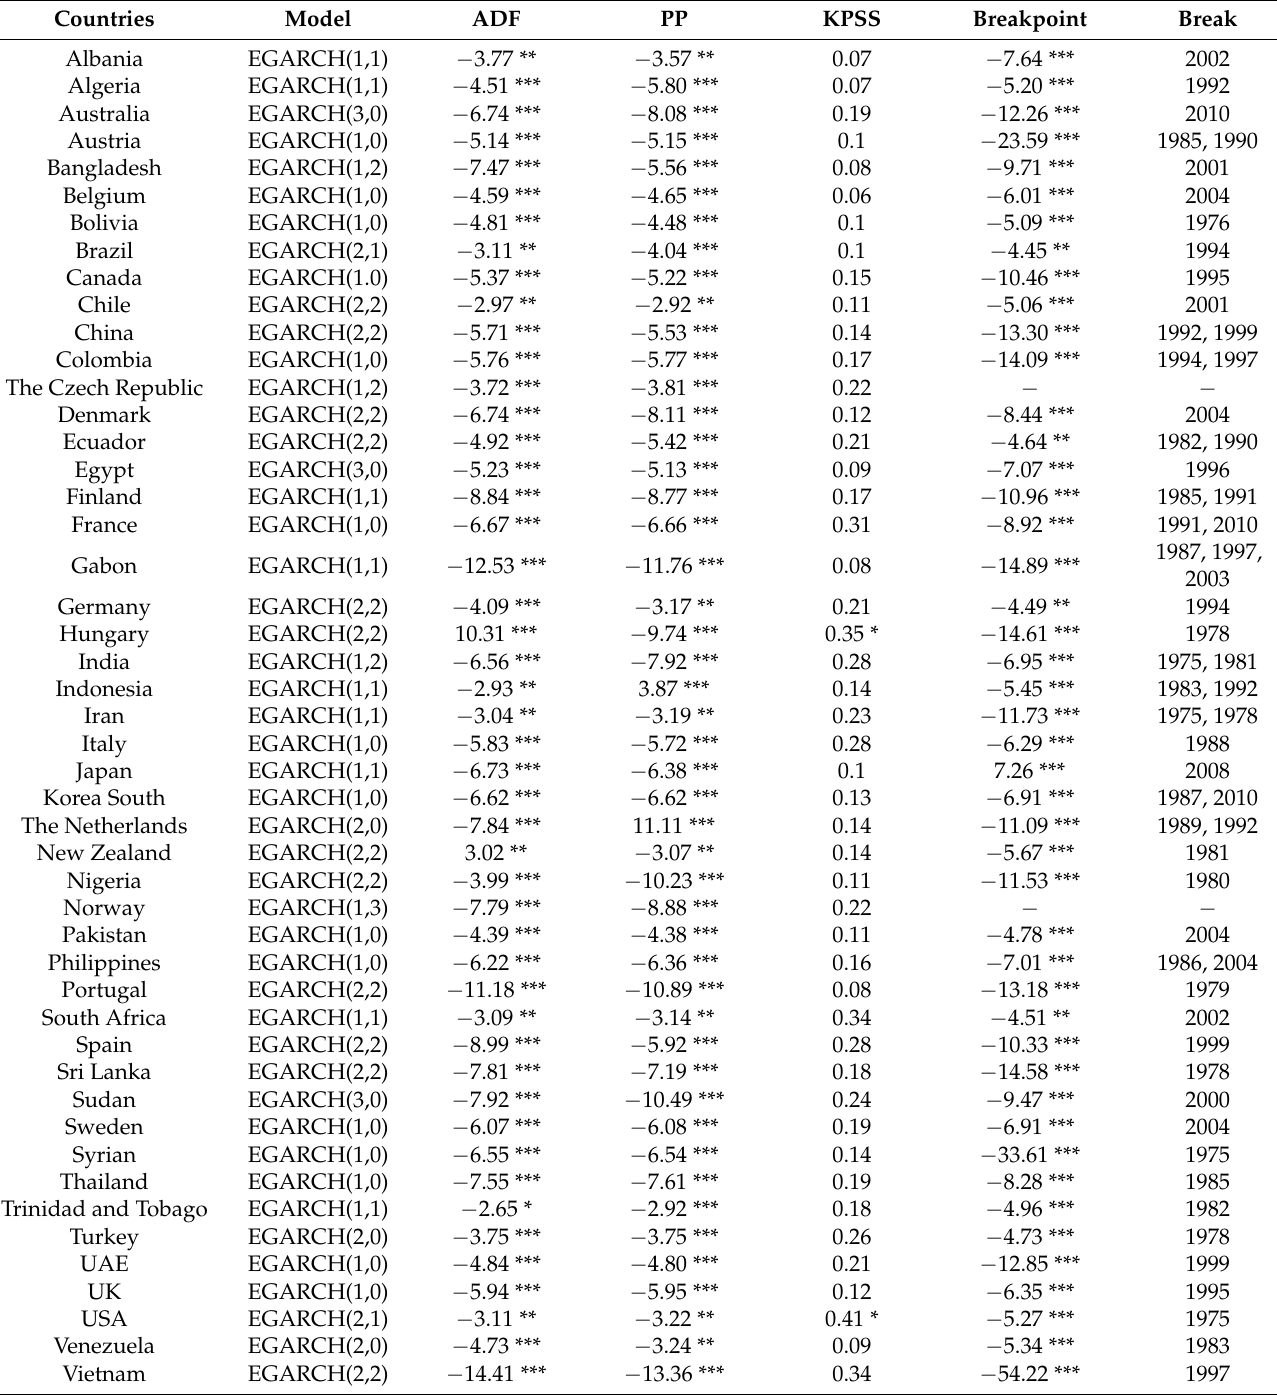
Table A3. Unit root test—income